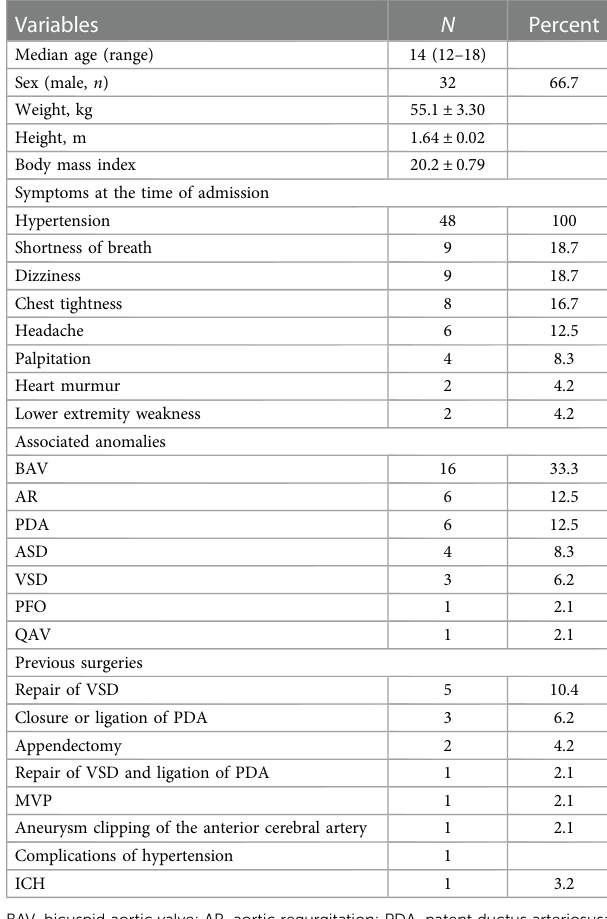
TABLE 1 Associated anomalies and previous